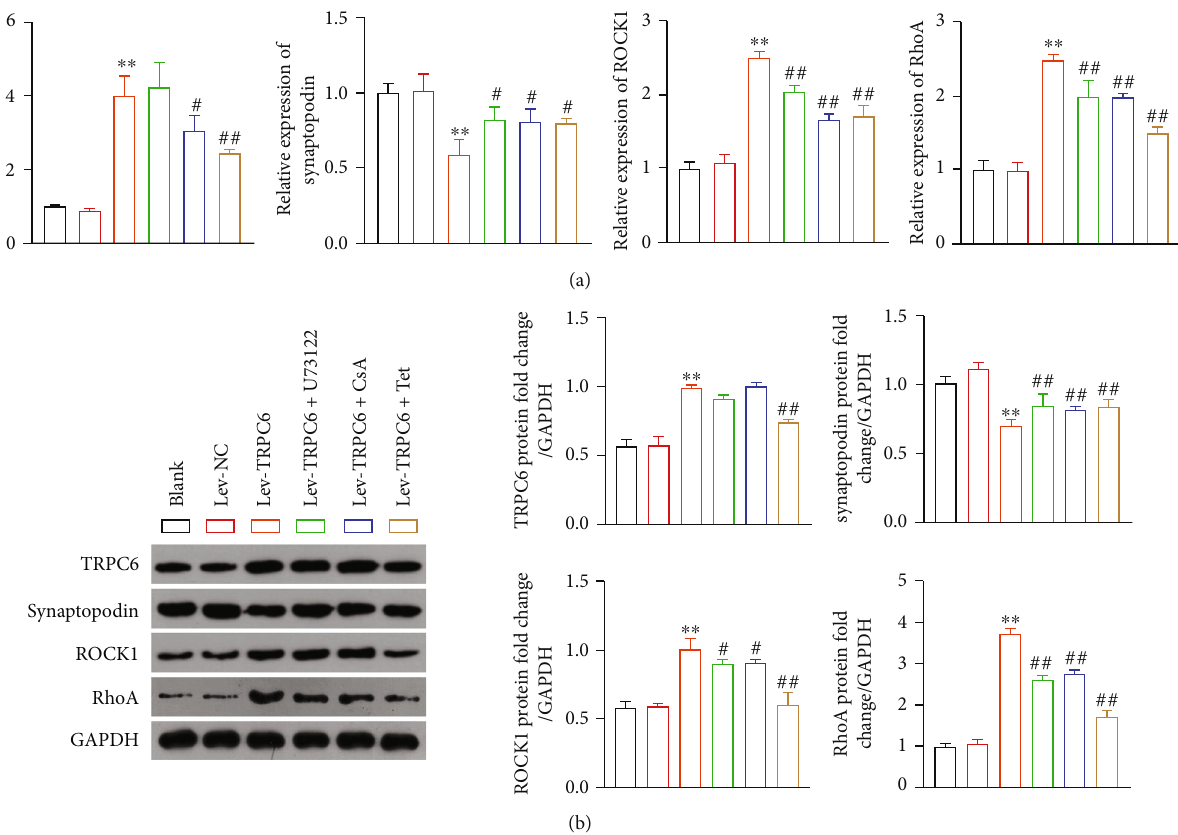
Figure 3: Tetrandrine (Tet) supresses the TRPC6-mediated RhoA/ROCK1 pathway in podocytes. (a) The mRNA expression of TRPC6, synaptopodin, RhoA, and ROCK1 in MPC5 podocytes was measured by RT-qPCR. (b) The protein expression of TRPC6, synaptopodin, RhoA, and ROCK1 in MPC5 podocytes was determined by western blotting. MPC5 podocytes were transfected with lev-NC or lev- TRPC6 and then treated with U73122 (an inhibitor of TRPC6 channel opening), CsA, or Tet. ∗∗ P < 0 : 01 versus the lev-NC group. # P < 0 : 05 and ## P < 0 : 01 versus the lev-TRPC6